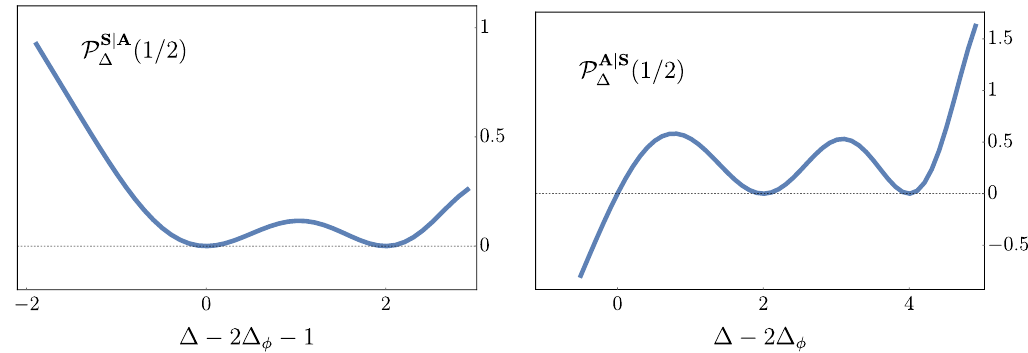
Figure 5 . Fermionic master functional. We consider the O ( n ) case with n = 3 and plot repre- sentative components of the fermionic Polyakov blocks P S crossing symmetric point z = 1 / 2